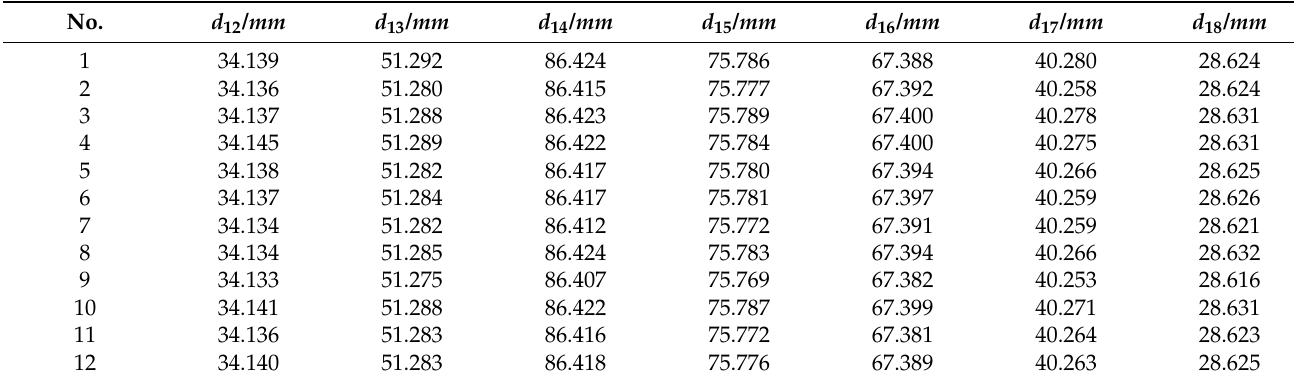
Table 3. Measurement results of the distance between the marked points.